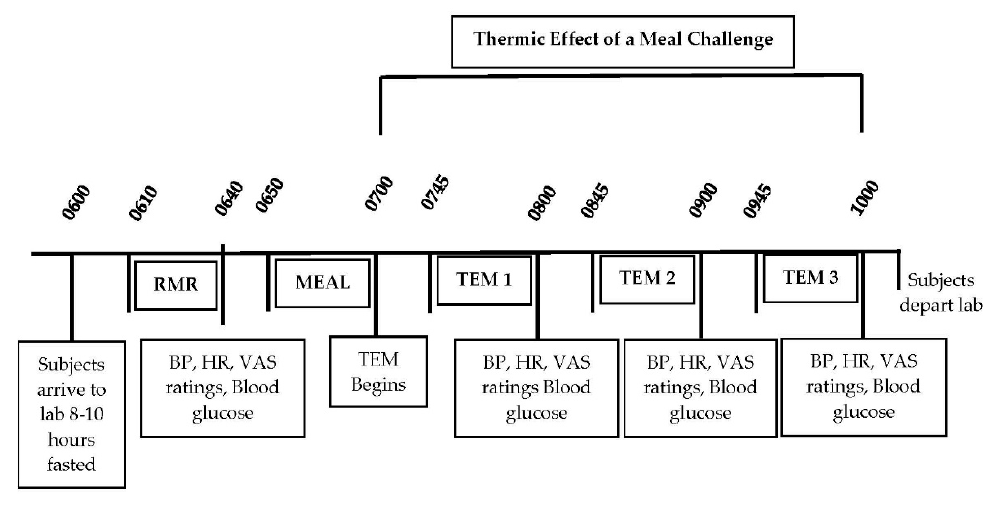
Figure 1. Timeline of Thermic E ff ect of a Meal (TEM) Test Days. RMR, resting metabolic rate; BP, blood pressure; HR, heart rate; VAS, visual analog scales for hunger, fullness, satiation, desire to